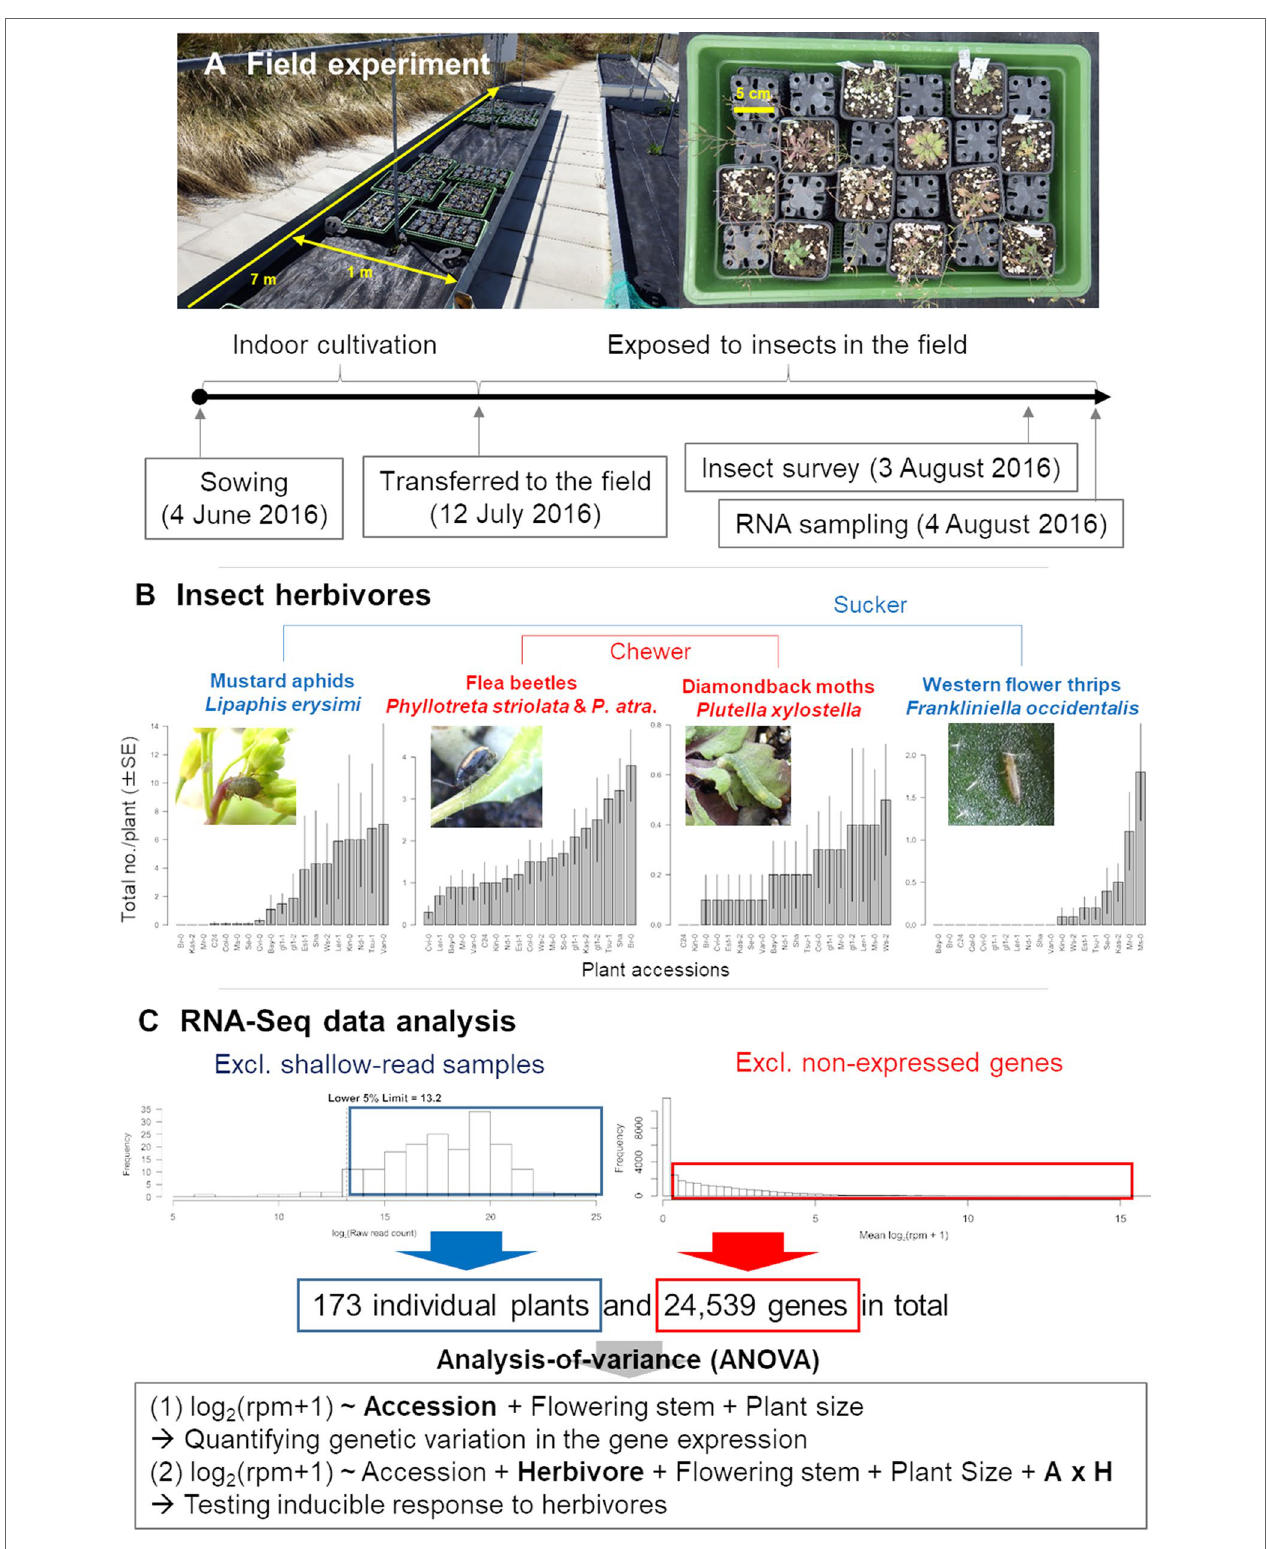
FIGURE 1 | Outline of the field study on A. thaliana . (A) Procedure of the field experiment. (B) Observed variation in insect abundance among plant accessions. (C) Filtering and statistical analysis of RNA-Seq data. In the ANOVA formula, “Herbivore” represents the main effect of the number of herbivores, while the “A × H” indicates the interaction term between the plant accession and the number of